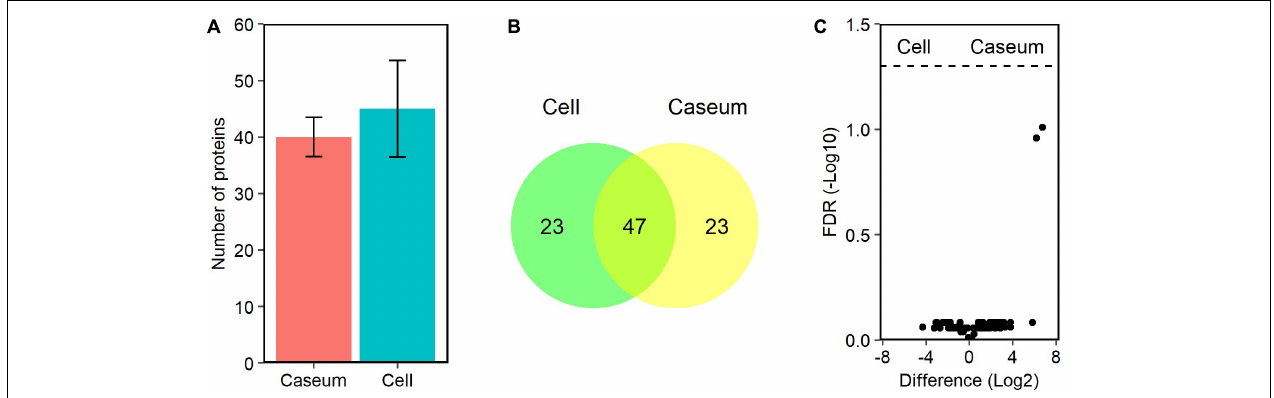
FIGURE 8 | Proteomic profiles of proteins derived from MAC in granulomatous lesions. (A) The average number and standard deviation of identified MAC proteins with LFQ values from MAC-LD granulomatous sub-compartments. (B) Venn diagrams comparing the number of identified MAC proteins in granulomatous lesions. The numbers of proteins detected in at least one sample among sub-compartments are indicated. (C) Volcano plot of protein abundance of identified MAC proteins between granulomatous sub-compartments. The logarithmic ratios of average fold changes and negative logarithmic FDR values of the Welch’s t -test between samples from caseous and cellular sub-compartments are plotted on the x- and y- axes,